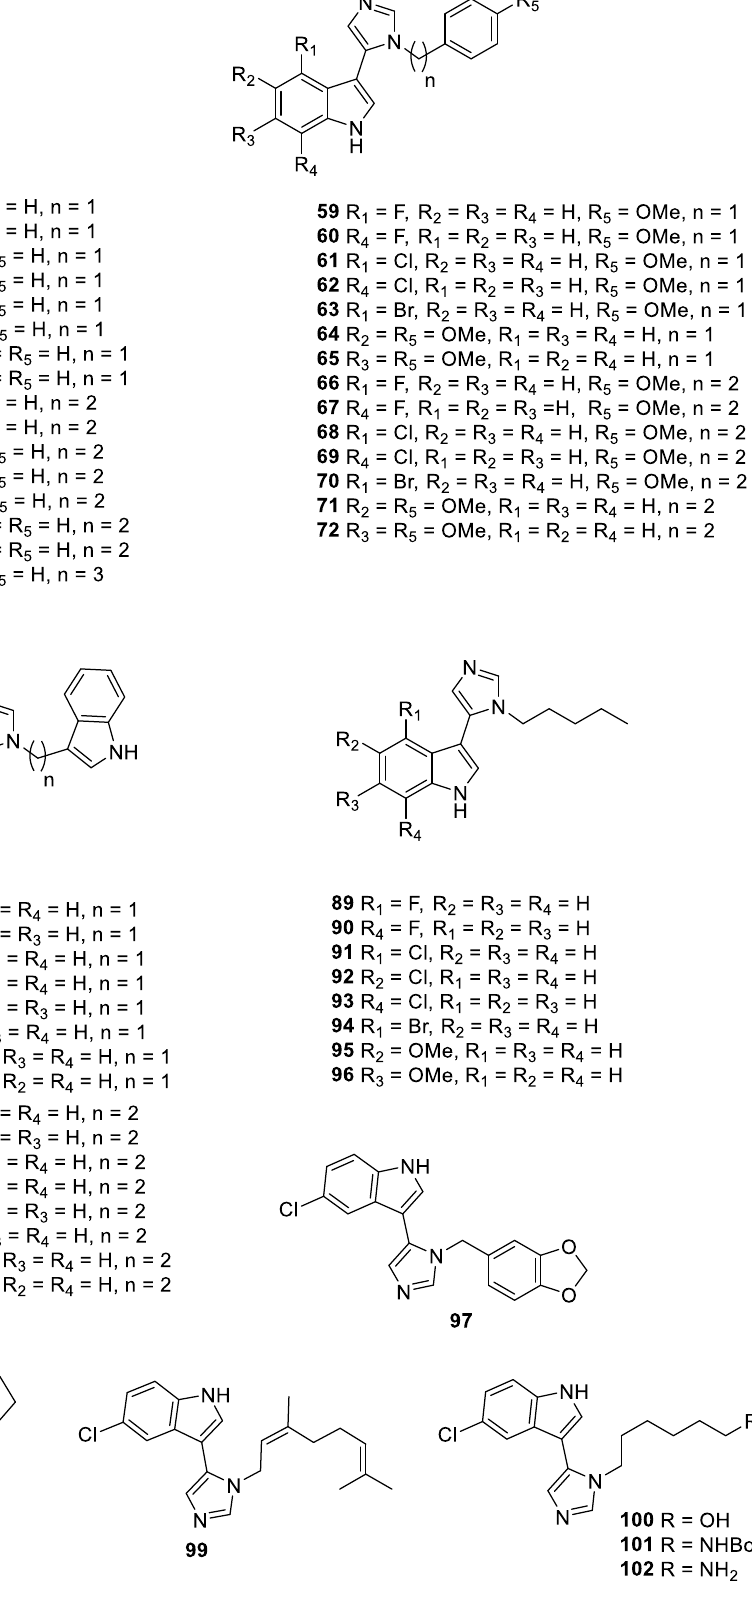
Figure 3. Structures of substituted indole-imidazoles 43 – 102 .